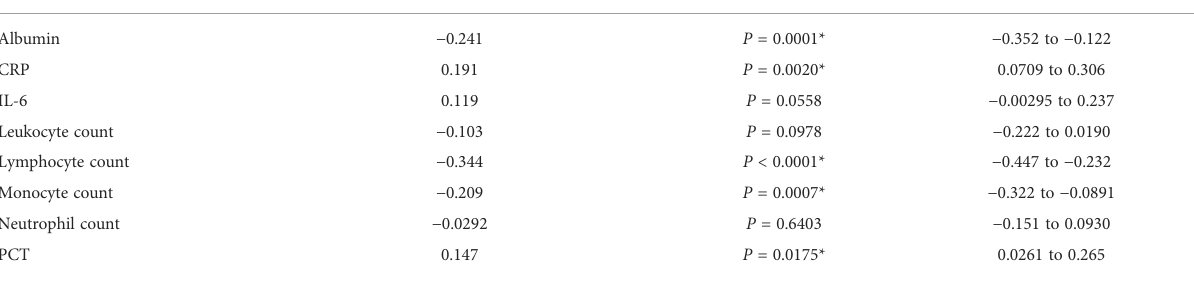
TABLE 4 The correlation between conventional indicators and fungal infection was analyzed using the Spearman ’ s method. Conventionalinfection